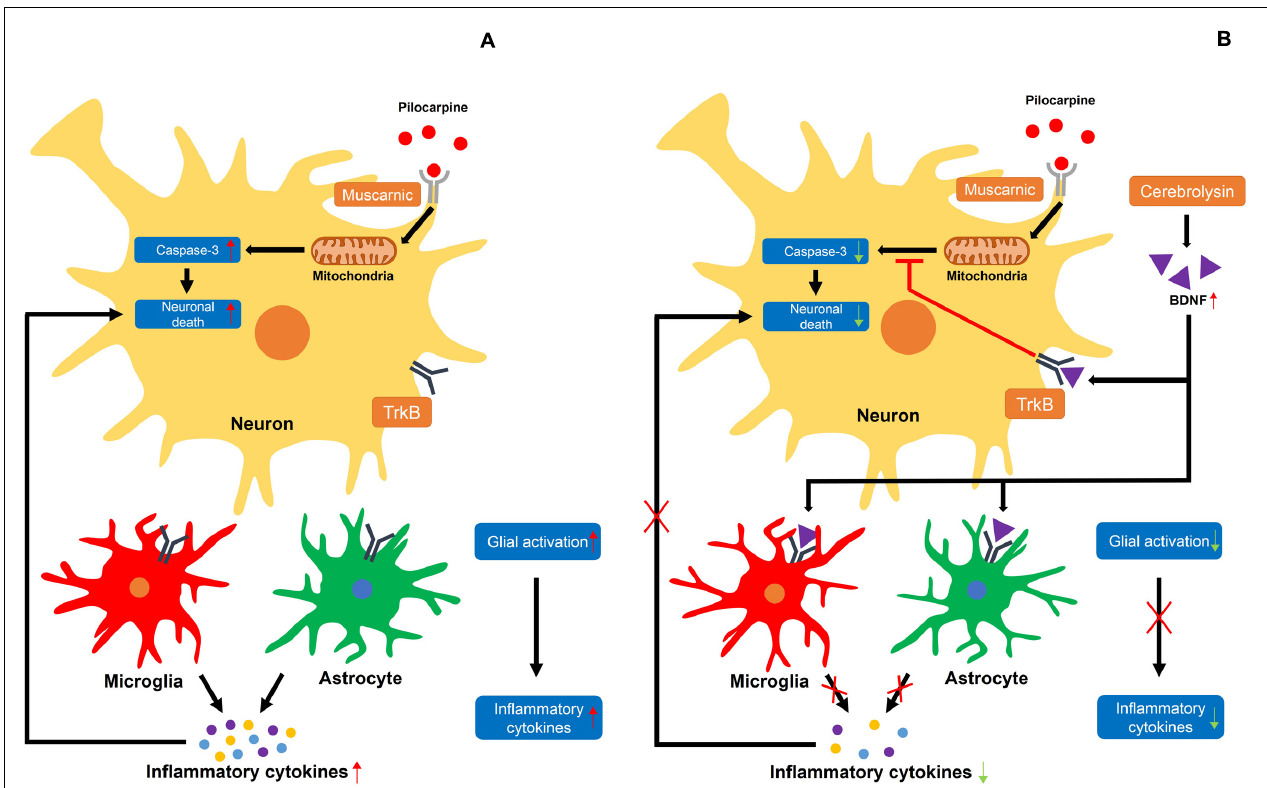
FIGURE 7 | Proposed mechanism for the effects of cerebrolysin on seizure-induced neuronal death. (A) A schematic drawing that proposes the possible cellular pathways through which a seizure may induce neuronal death. (A) The damage caused by excessive neuronal excitation when pilocarpine is bound by a muscarinic receptor increases caspase-3-dependent neuronal death. In addition, activated glial cells secrete inflammatory cytokines, increasing neuronal death. (B) Increased BDNF levels by cerebrolysin can result in the inhibition of caspase-3 and glial activation, which are thought to occur following pilocarpine-induced seizure. A red X indicates